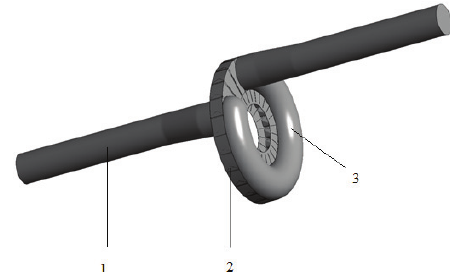
Figure 2. 3D model of a side channel pump.